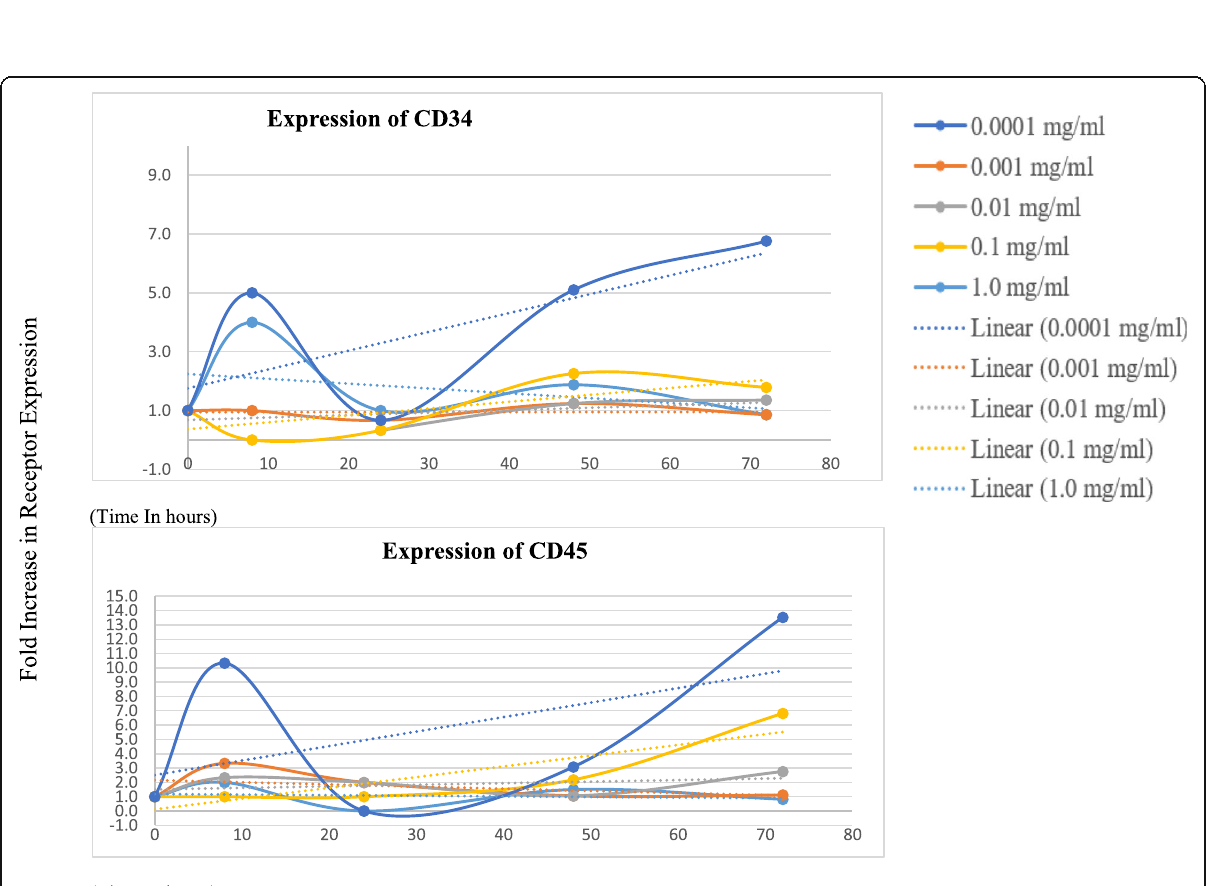
Fig. 3 Flow Cytometry Analysis for Expression of CD34 and CD45 at various concentration of StemForte